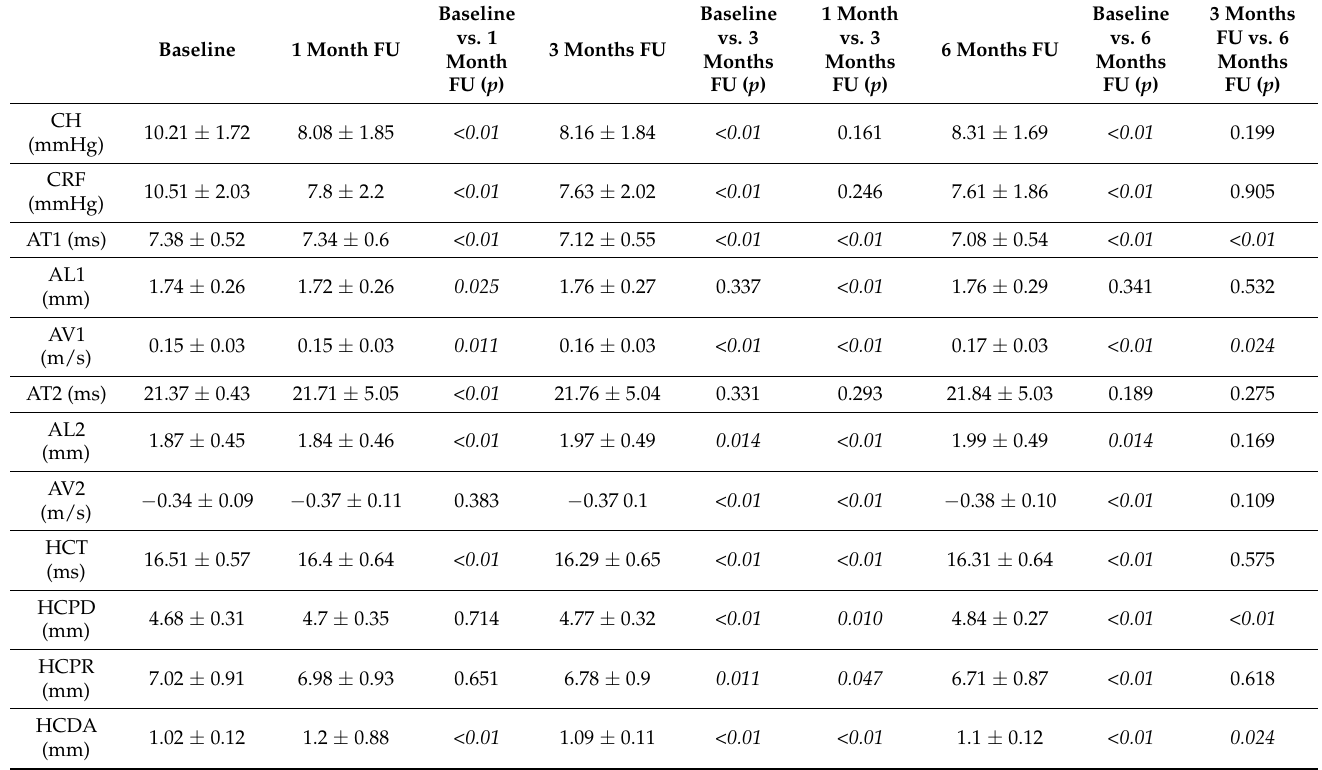
Table 2. The means ± standard deviations of corneal biomechanical properties (CBP) evaluated both with ORA Ocular Response Analyzer (ORA) and Corvis ST (CST), measured before photorefractive keratectomy (PRK) and at 1, 3 and 6 months follow-up